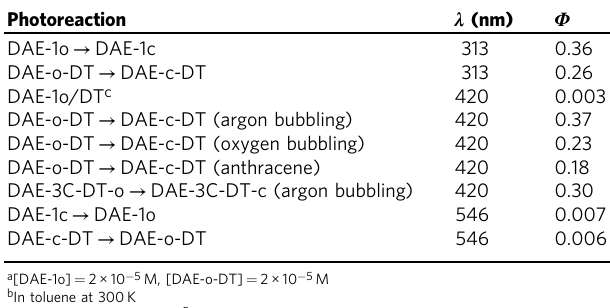
Table 1 Photoreaction quantum yields of diarylethenes a at the depicted wavelengths ( λ ) b